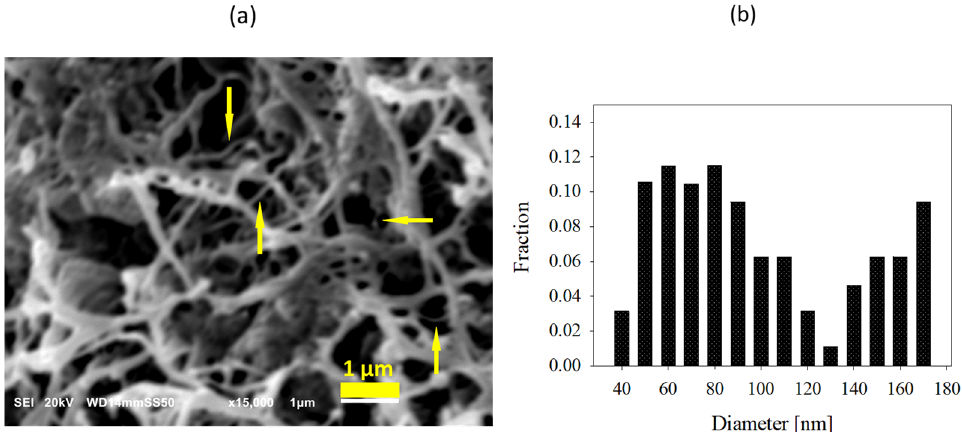
Figure 3. ( a ) SEM image of dis-UHMWPE nanofiber network in nanocomposite processed at 115 °C for 30 min. Thicker fibers are bundles consisting of several thinner nanofibers, as pointed out by arrows; ( b ) diameter distribution of the nanofibers.